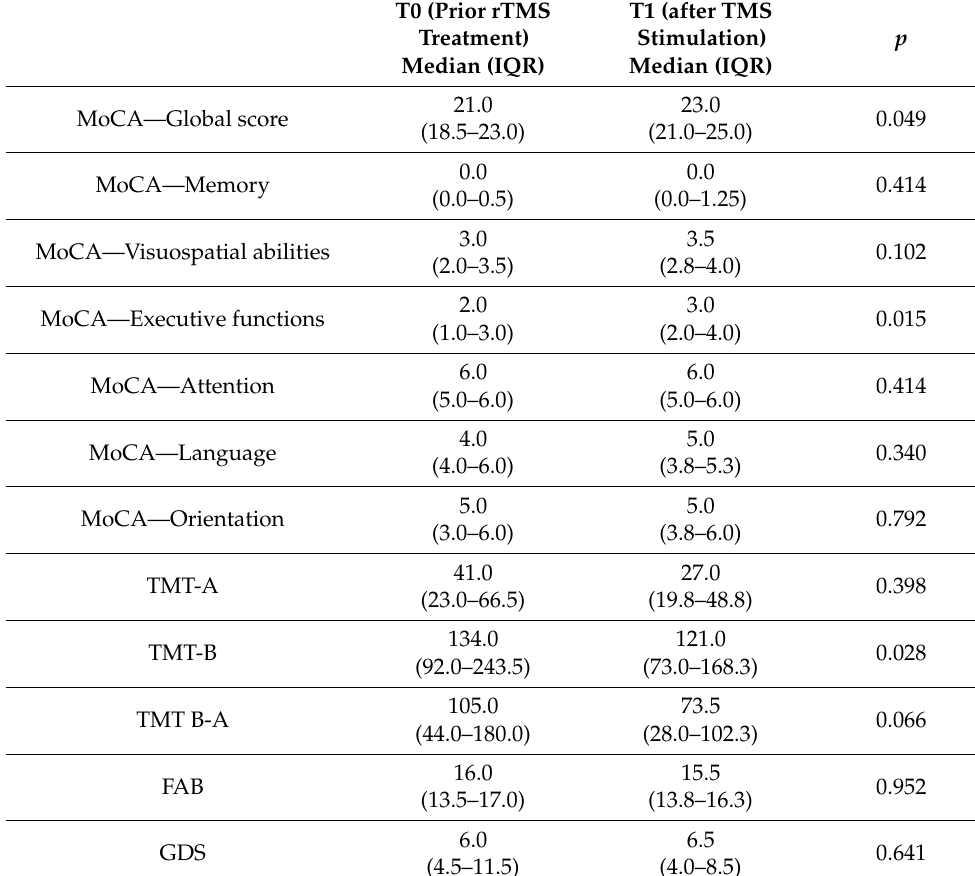
Table 2. Comparison between T0 and T1 for cognitive and emotional